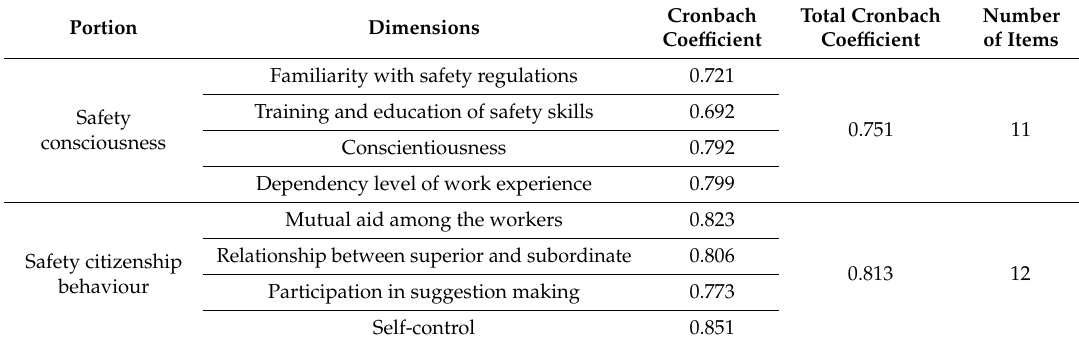
Table 7. Overall reliability of the questionnaire.